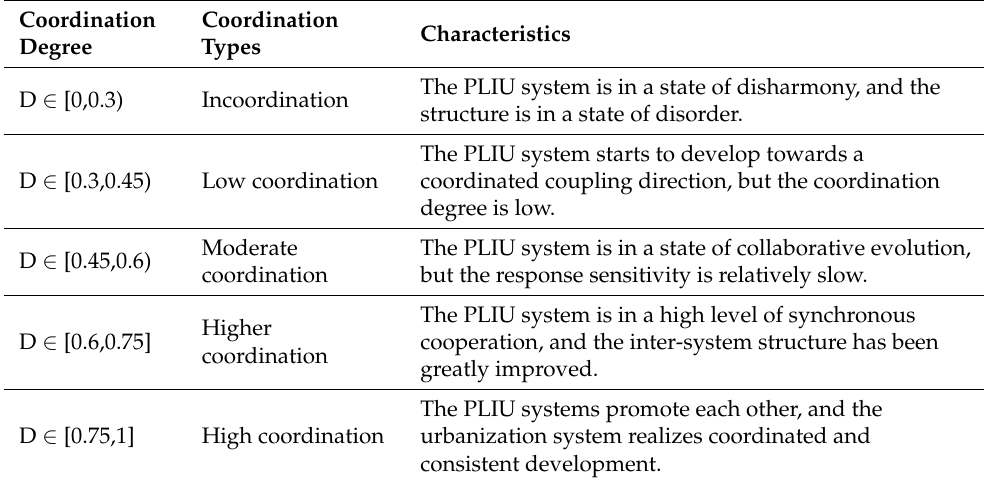
Table 2. Classification of PLIU coordination degree.